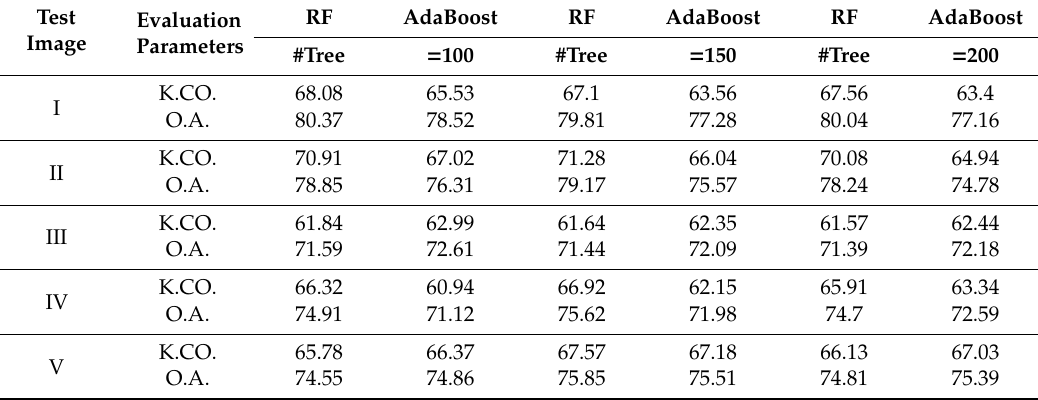
Table 3. Comparisons with ensemble classification methods in di ff erent modes.